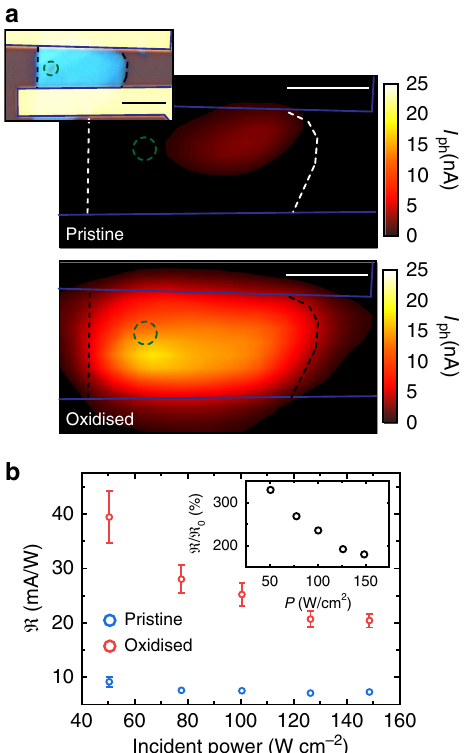
Fig. 3 Photo-response of HfS 2 /HfO 2 engineered device. a SPCM map of the device before (top) and after (bottom) laser-assisted oxidation. V sd = − 5 V, V = 50 V, λ = 473 nm, P = 150 W cm − 2 and 0.5 μ m step size. Inset: bg optical micrograph of the device, after laser-assisted oxidation of a single spot (green dashed circle). Scale bars are 3 μ m. b Responsivity before (blue, < 0 ) and after (red, < ) laser-assisted oxidation as a function of incident optical power. Inset: ratio < = <